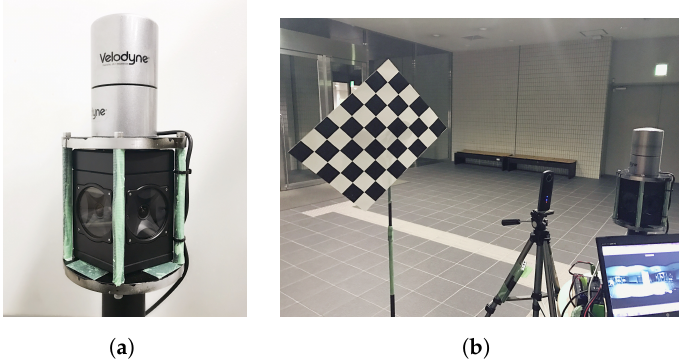
Figure 9. Setup. ( a ) the image of the setup for two sensors; ( b ) a scene for the data acquisition.